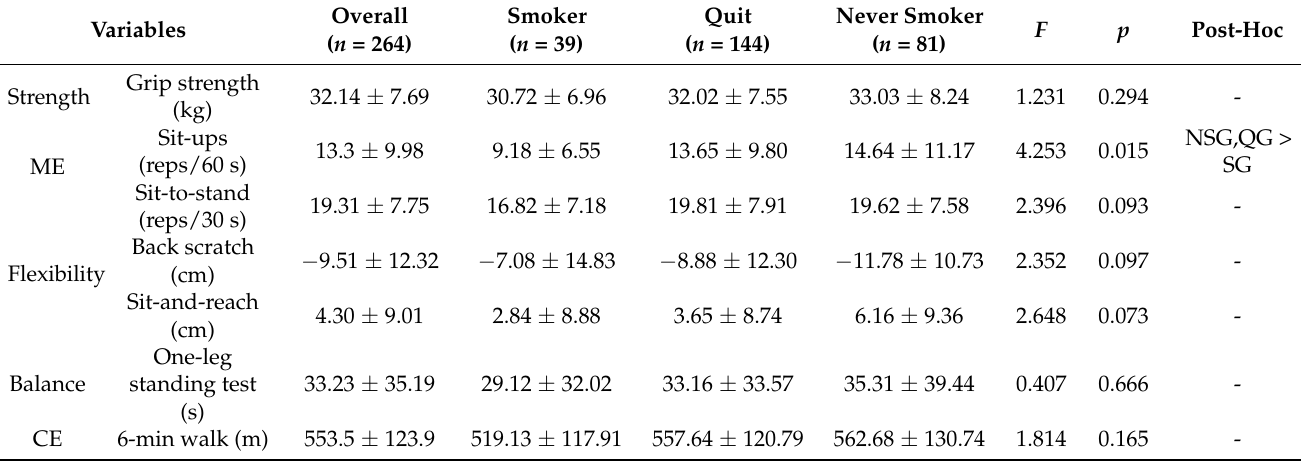
Table 4. Differences in physical fitness variables based on smoking in elderly